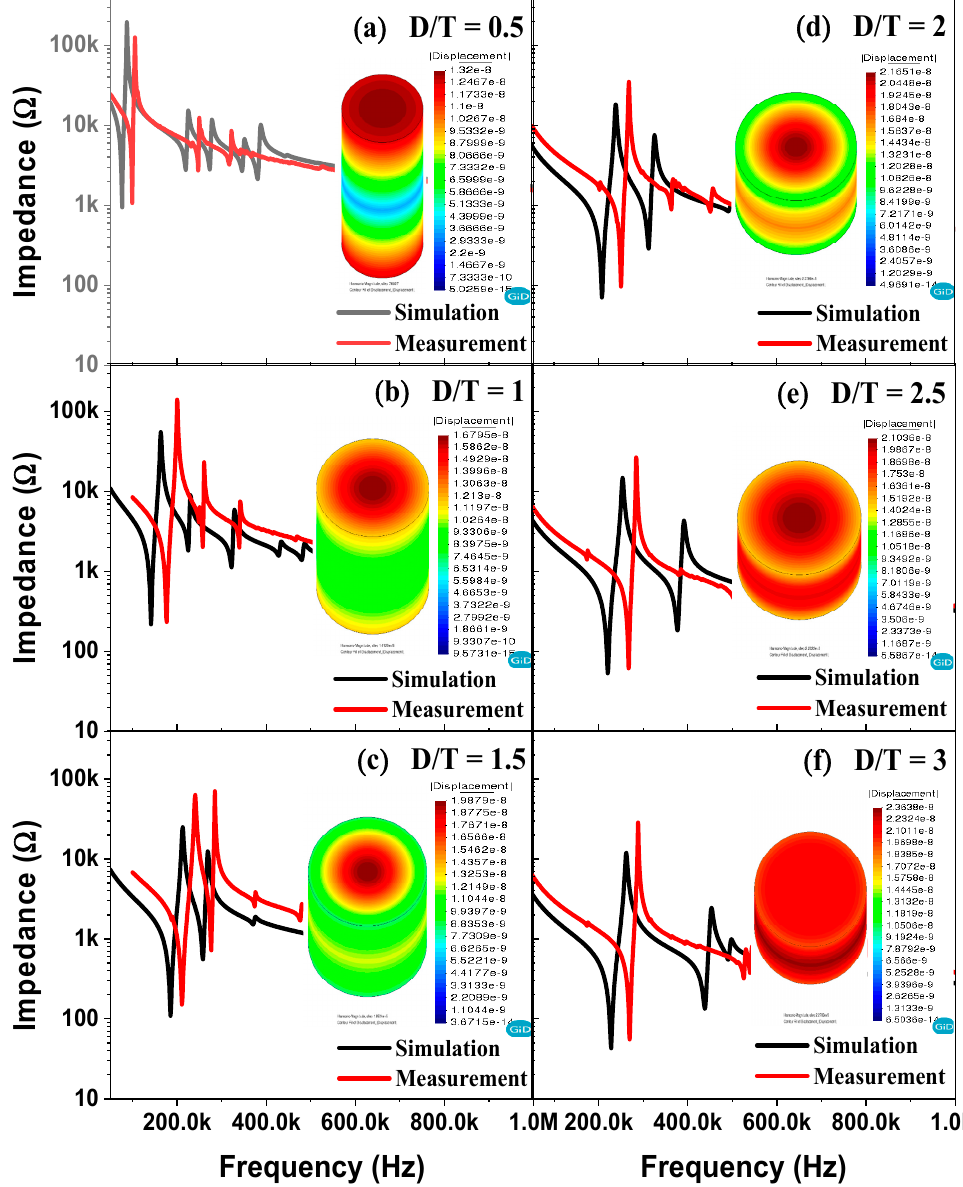
Figure 4. Impedance’s magnitude vs. frequency and displacement of BZT–BCT ceramics at resonant frequency vs. the D/T ratio by ATILA simulation: ( a ) D/T = 0.5, ( b ) D/T = 1, ( c ) D/T = 1.5, ( d ) D/T = 2, ( e ) D/T = 2.5, ( f ) D/T = 3.